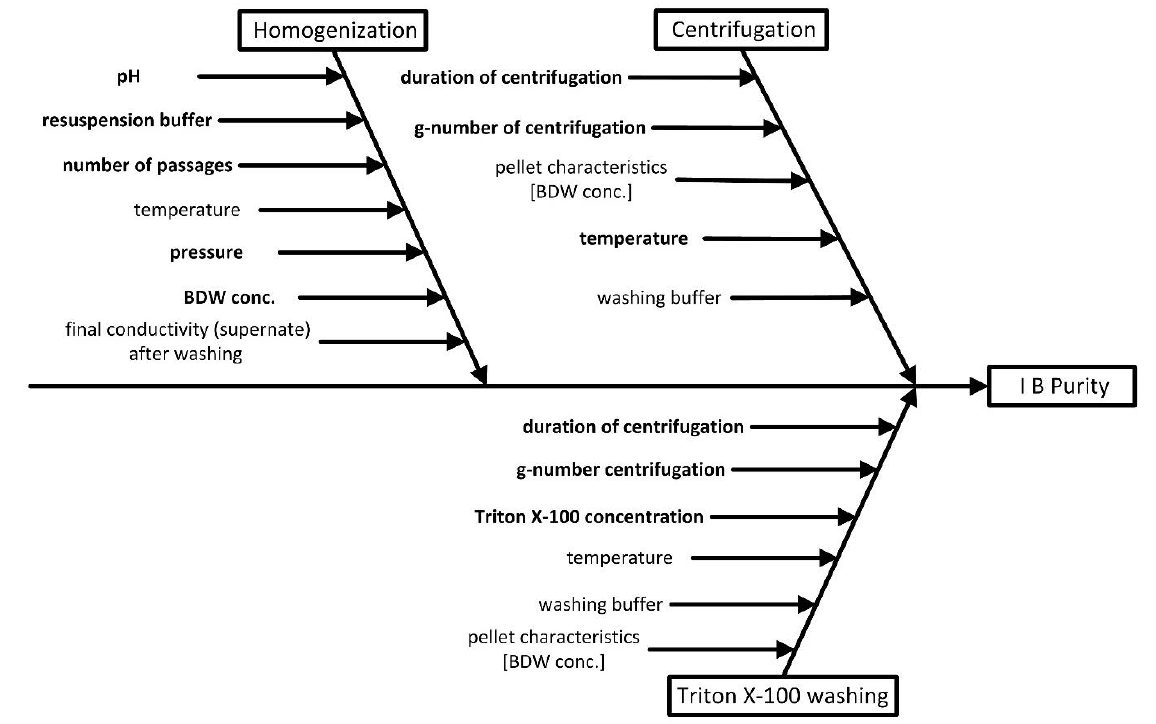
Figure 4. Interaction block comprising potentially interacting unit operations.